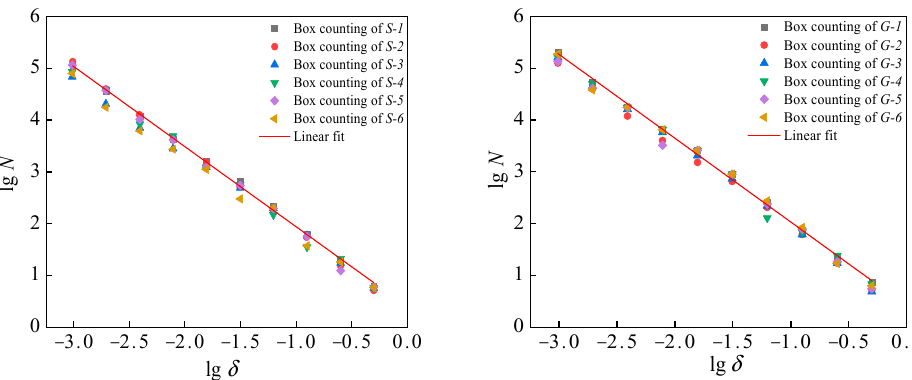
Figure 3. Failure patterns of some specimens under static load (slate and granite).